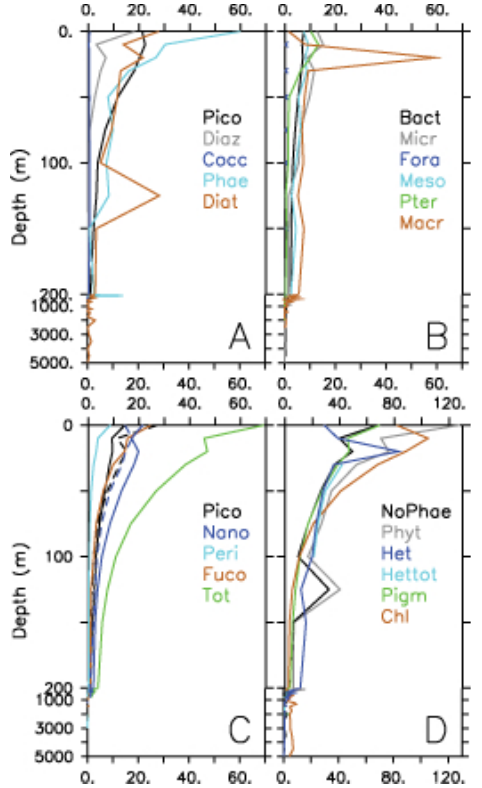
Figure 2. Depth profiles of average PFT biomass [ µ gCL − 1 ]. (A) Autotrophs from abundance. Black, “Pico”: picophytoplank- ton; grey, “Diaz”: diazotrophs; blue, “Cocc”: coccolithophores; cyan, “Phae”: Phaeocystis ; brown, “Diat”: diatoms. (B) Het- erotrophs from abundance. Black, “Bact”: picoheterotrophs; grey,